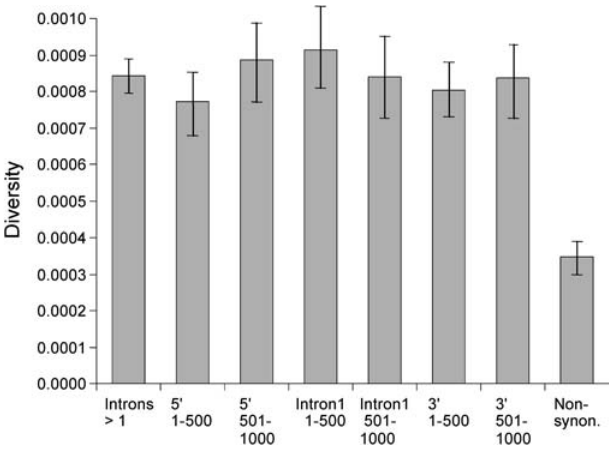
Figure 3. Mean Nucleotide Diversity in Human Intergenic DNA in Blocks of 500 Bases Upstream and Downstream of Genes Data shown separately for first introns, introns excluding first introns ( ‘‘ Introns . 1 ’’ ), and nonsynonymous sites.